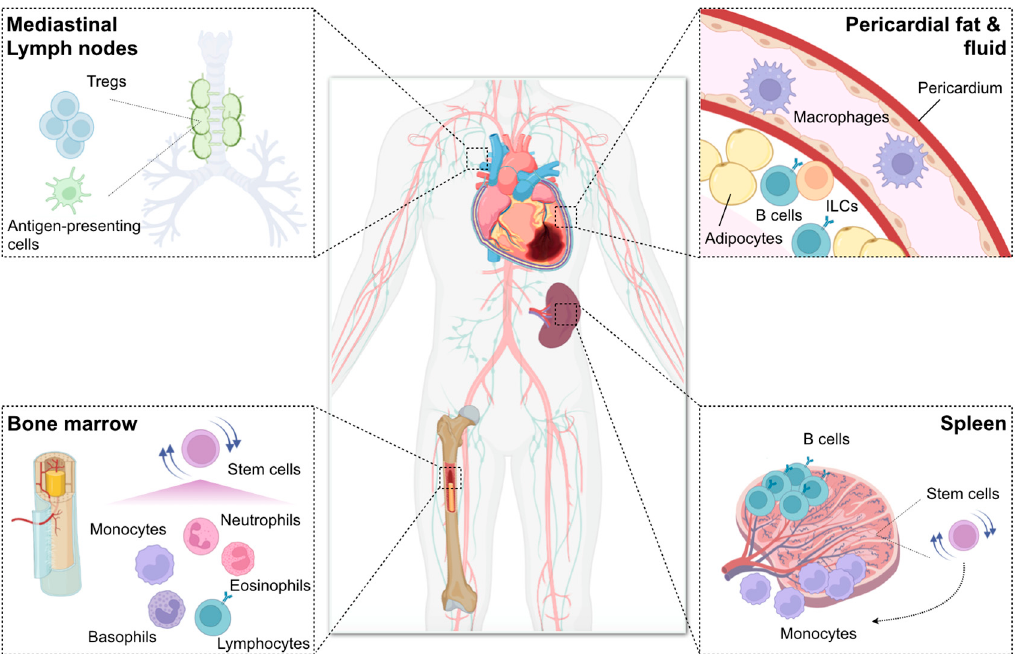
Figure 2. Remote organs contributing to immune and inflammatory networks after myocardial infarction (MI). Bone marrow generates billions of immune cells and supplies them to the injured heart, thereby essentially contributing to the immune inflammatory response after MI. Infarct-derived inflammatory cytokines (e.g., interleukin [IL]-1 β ), damage-associated molecular patterns (e.g., S100A8), and growth factors (e.g., granulocyte-macrophage colony-stimulating factor [GM-CSF]) as well as increased sympathetic nervous signals stimulate bone marrow hematopoietic stem cell proliferation and immune cell production. Spleen also has stem cells and produces mainly myeloid cells in a process known as extramedullary hematopoiesis. Splenic reservoir monocytes exit the spleen and accumulate in injured tissue depending on angiotensin II signaling during the first day of MI. The miR21/HIF-1 α axis in splenic marginal zone B cells is essential for C-C motif chemokine ligand 7 production, thereby promoting inflammatory monocyte mobilization to the infarcted heart. B cells also reside in pericardial adipose tissue where GM-CSF-producing B cells potentially enhance infarct inflammation, whereas IL-10-producing CD5 + B cells promote the res- olution of MI-induced inflammation. Innate lymphoid cells (ILCs) also expand in the pericardial adipose tissue after MI and exhibit beneficial function. Pericardial fluid contains a discrete subset of macrophages expressing GATA binding protein 6, which may be protective against diastolic heart failure following MI. Mediastinal lymph nodes are heart-draining lymph nodes where regulatory T cells (Tregs) expand and proliferate with antigen presentation to regulate repair of the ischemic myocardium. 4. Clonal Hematopoiesis: An Emerging Protagonist Promoting CVD As we age, somatic mutations accumulate in bone marrow HSPCs, some of which confer a competitive advantage or fitness, leading to clonal expansion of the mutated cells. Consequently, the bone marrow expels clonal descendants of the mutant stem cells into peripheral circulation, resulting in more than 10% of individuals by age 70 with these clones accounting, on average, for up to 20% of their peripheral leukocytes. The presence of such clones, referred to as clonal hematopoiesis, indicates a premalignant condition capable of developing into hematologic cancers such as acute myeloid leuke- mia and myelodysplastic syndromes, albeit with a rare progression rate. Although there has been little information regarding the role of age-related clonal hematopoiesis on chronic disorders, recent epidemiological studies with exome sequence analyses showed that clonal hematopoiesis is associated with an approximately 40% increased cardiovas- cular risk, independent of traditional risk factors [97,98]. The incidence of cardiovascular